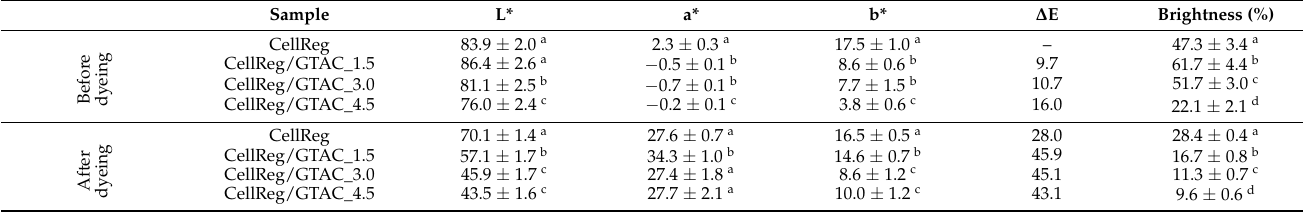
Colorimetric coordinates and brightness of the CellReg, CellReg/GTAC_1.5, Cell- Reg/GTAC_3.0 and CellReg/GTAC_4.5 before and after the dye uptake tests 1